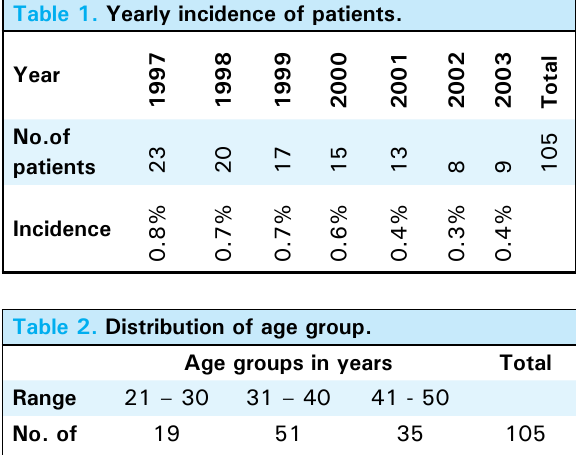
table 1. Yearly incidence of patients.